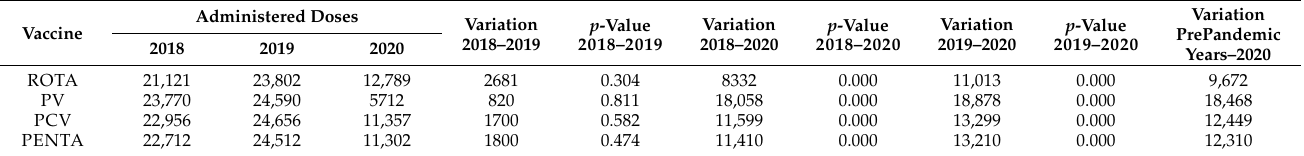
Table 3. Last administered vaccination doses for infants during April 2018–2020 in Ecuador.